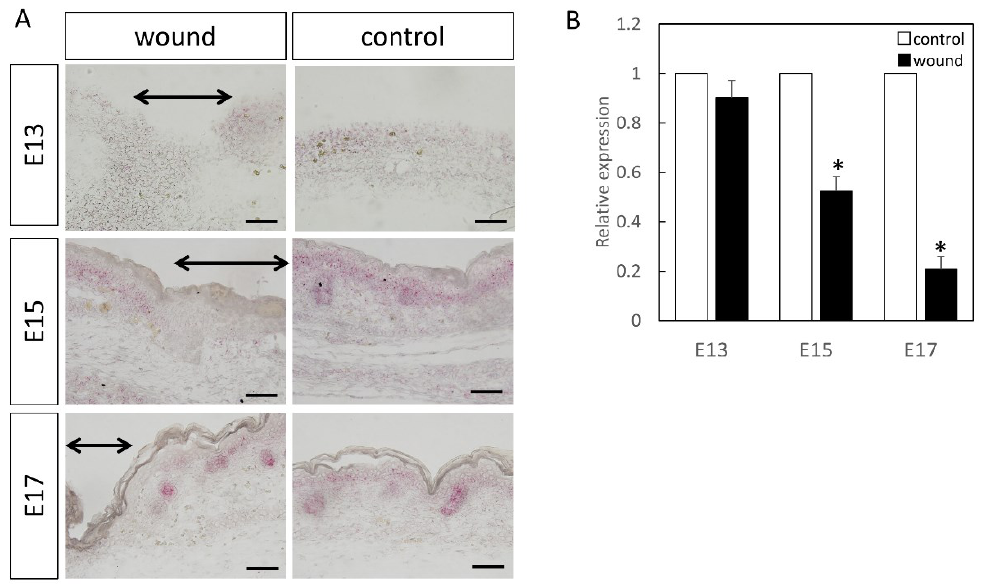
Figure 5. Localization of Axin2 (Red) in the wound. The range of the wound is indicated by an arrow. Results of Axin2 localization by ( A ) in-situ hybridization and ( B ) real-time PCR. At E13, expression did not change at the wound site, but decreased on E15 and 17. * p < 0.05. black arrow; area of the wound. Scale bar = 100 μm.